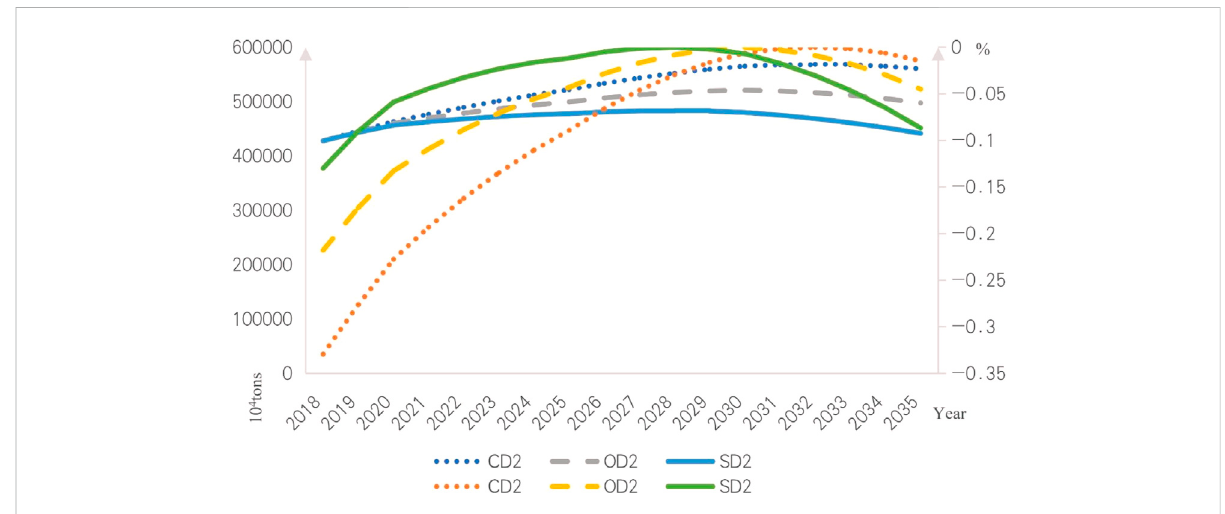
FIGURE 8 Gap between China ’ s coal consumption and peak value under CD2-OD2-SD2 scenario from 2018 to